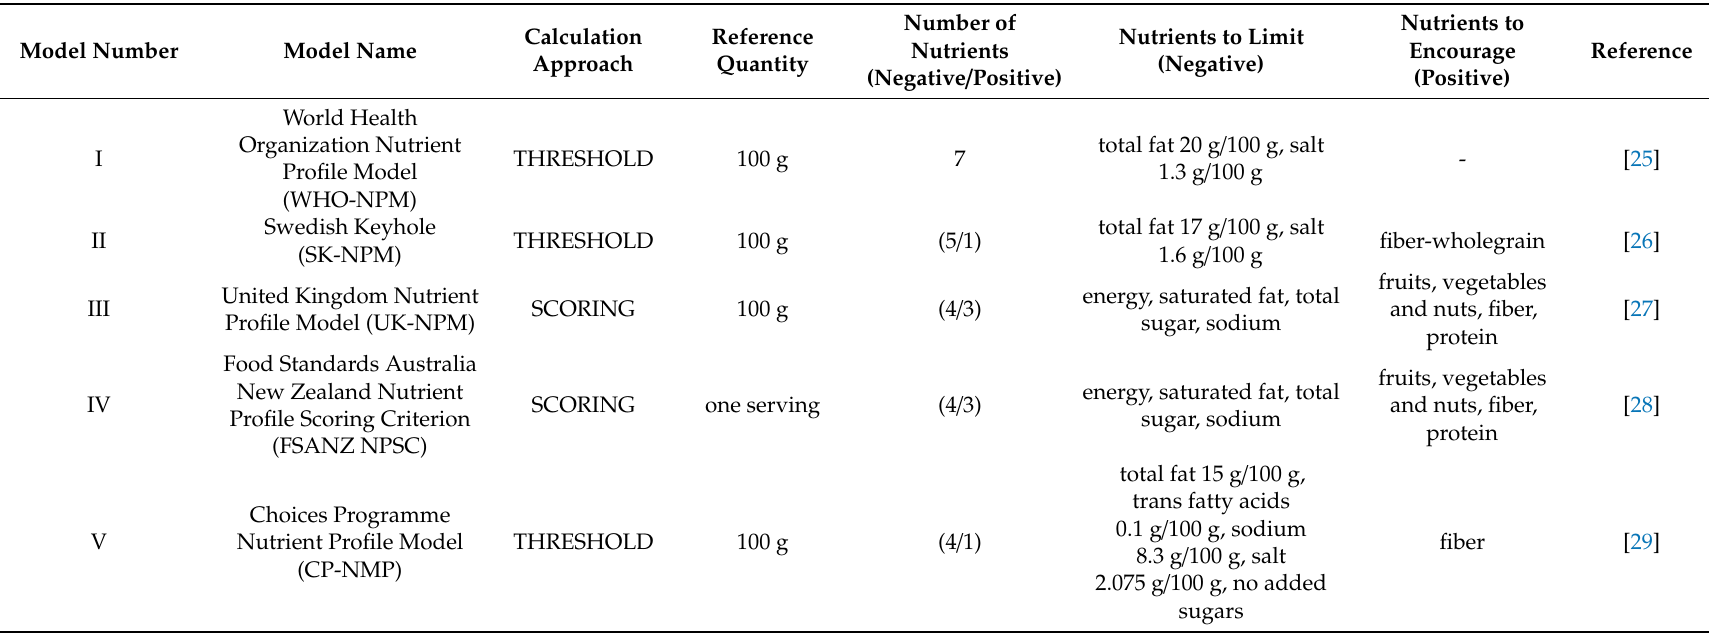
Table 1. Overview of the five chosen nutrient profile models and their key